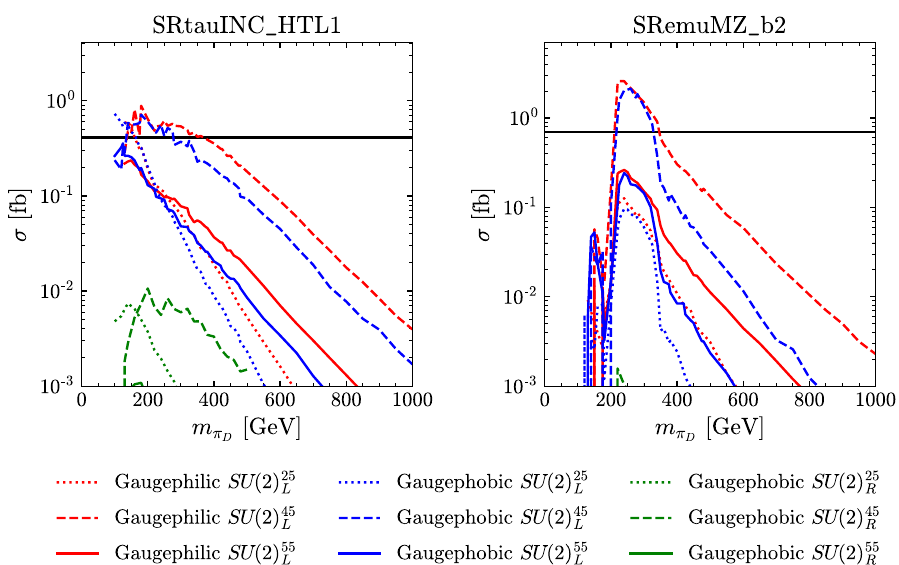
Figure 9 . Expected signal cross section in two different signal regions of the ATLAS multilepton search [148] as a function of dark pion